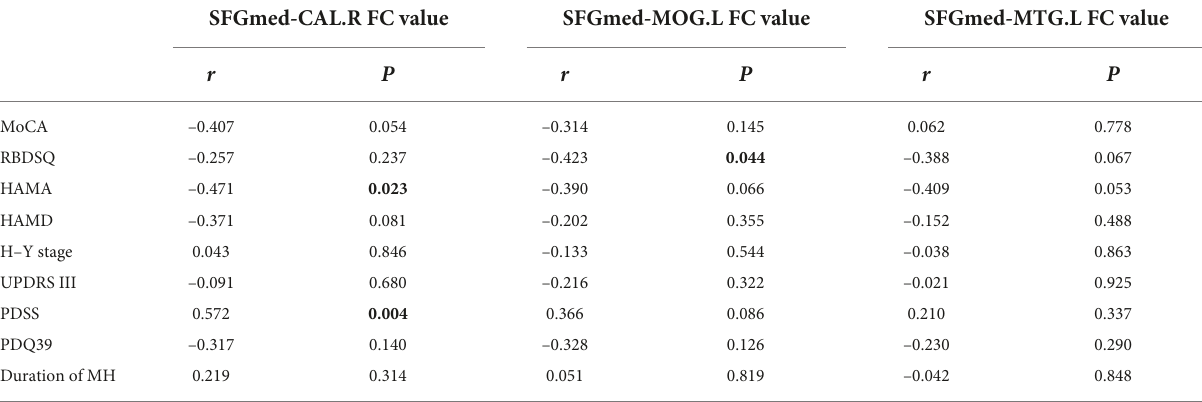
TABLE 4 Correlation analysis between FC values and scale scores in PD-MH